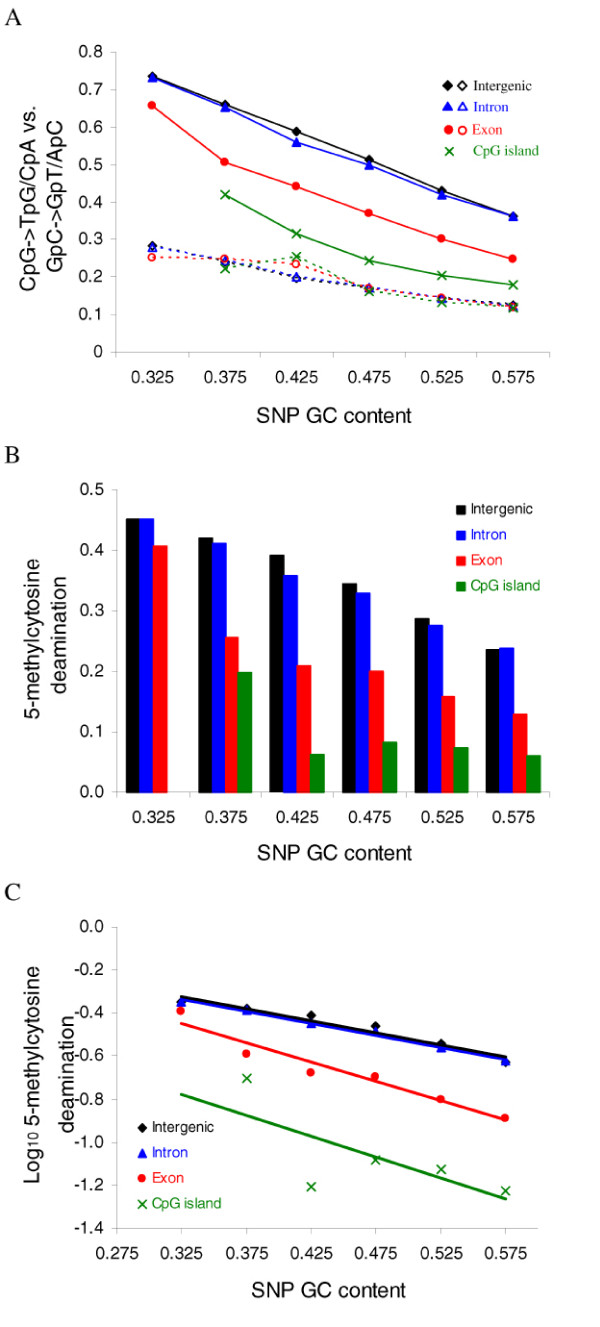
Rates of CpG transition, GpC transition, and 5mC deamination varied with local GC content and among the genomic regions. (A) Rates of CpG→TpG/CpA per CpG dinucleotide (solid line) and GpC→GpT/ApC per GpC dinucleotide (dashed line) in the SNP flanking sequences (length category 101 nt). In CpG islands, the rates at GC content bin 0.325 were not calculated due to the insufficient number of SNPs. (B) 5mC deamination rates, measured by the difference between the rates of CpG transition and GpC transition in A. (C) Plot of log10(5mC deamination rate) versus SNP GC content.